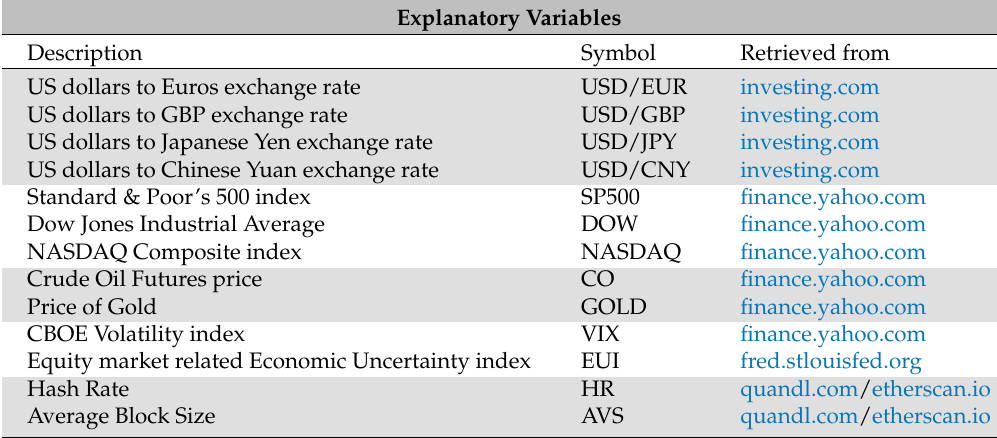
Table 1. List of variables and online resources. The Hash Rate (HR) and Average Block Size (AVS) have been retrieved from quandl.com for Bitcoin and from etherscan.io for Ether.